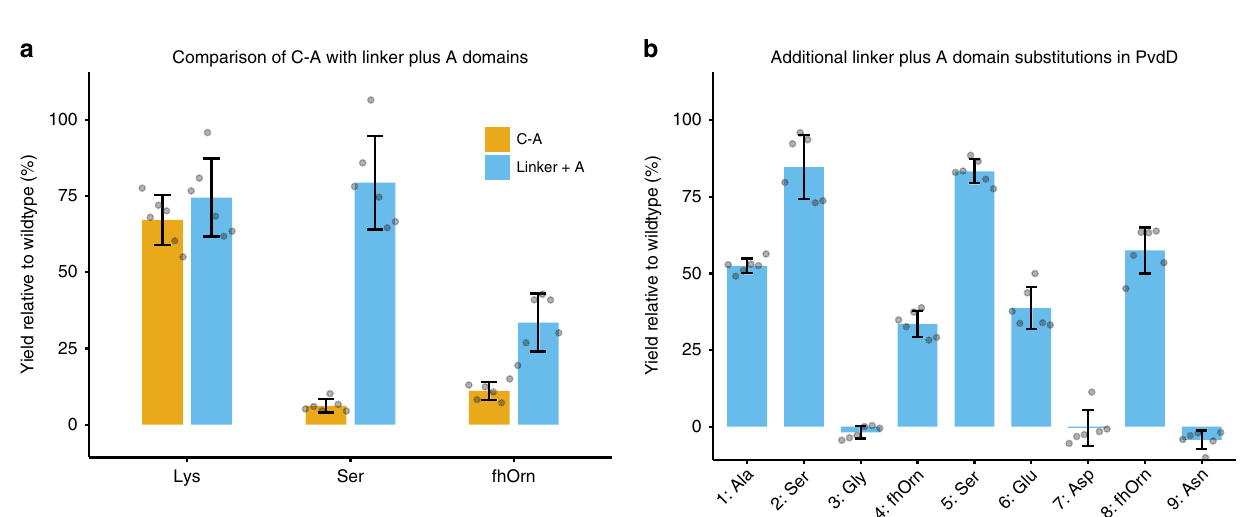
Fig. 3 Ef fi cient generation of modi fi ed pyoverdines by linker + A domain substitutions. a Pyoverdine production for C-A domain substitution strains compared with the corresponding linker + A domain substitution strains. b Pyoverdine production for nine additional A + linker domain substitution variants. Pyoverdine production was assessed by measuring absorbance at 400 nm relative to a wild-type P. aeruginosa strain. In all cases, n = 6 independent experiments and data are presented as mean values ± SD. Source data are provided as a Source Data fi le. The abbreviation fhOrn represents N 5 -formyl-N 5